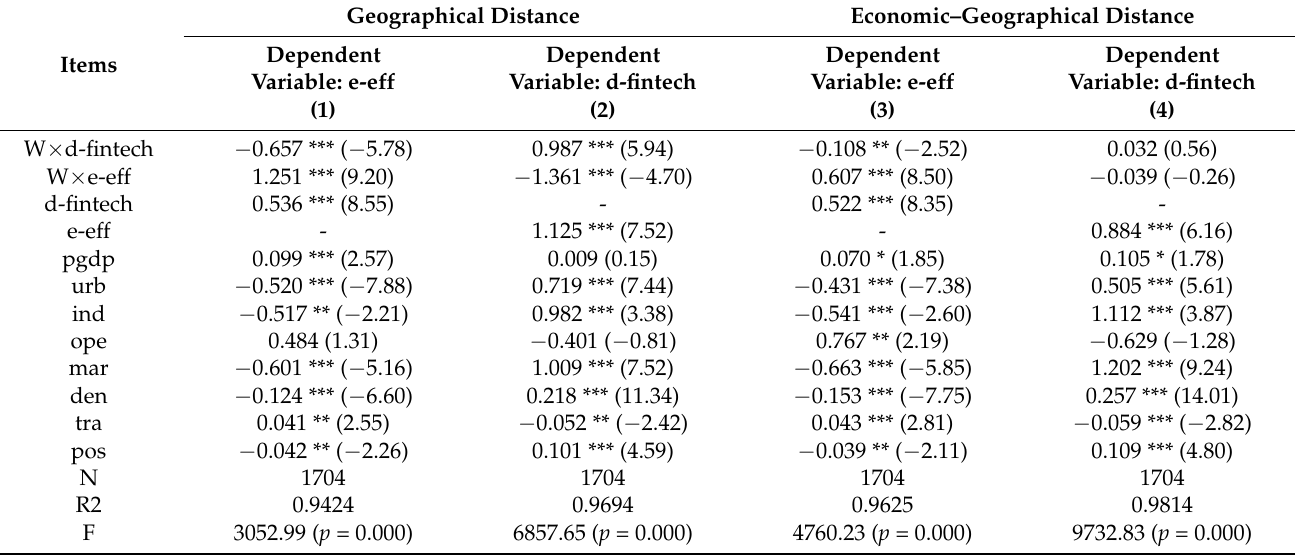
Table 12. Period estimation results of GS3SLS